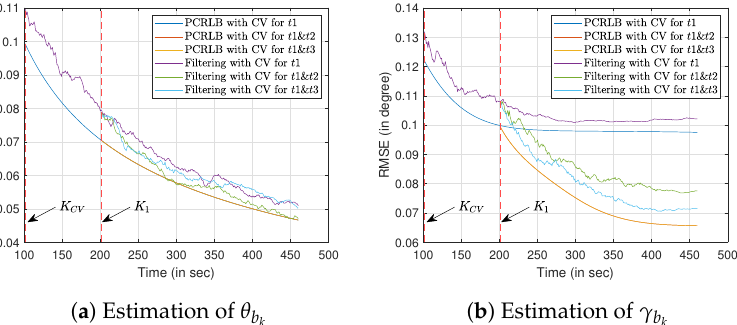
Figure 9. RMSE evaluation for bias estimation using two targets of opportunity with known lo- cation and terrain uncertainty. The second target of opportunity is located on either side of the sensor trajectory.